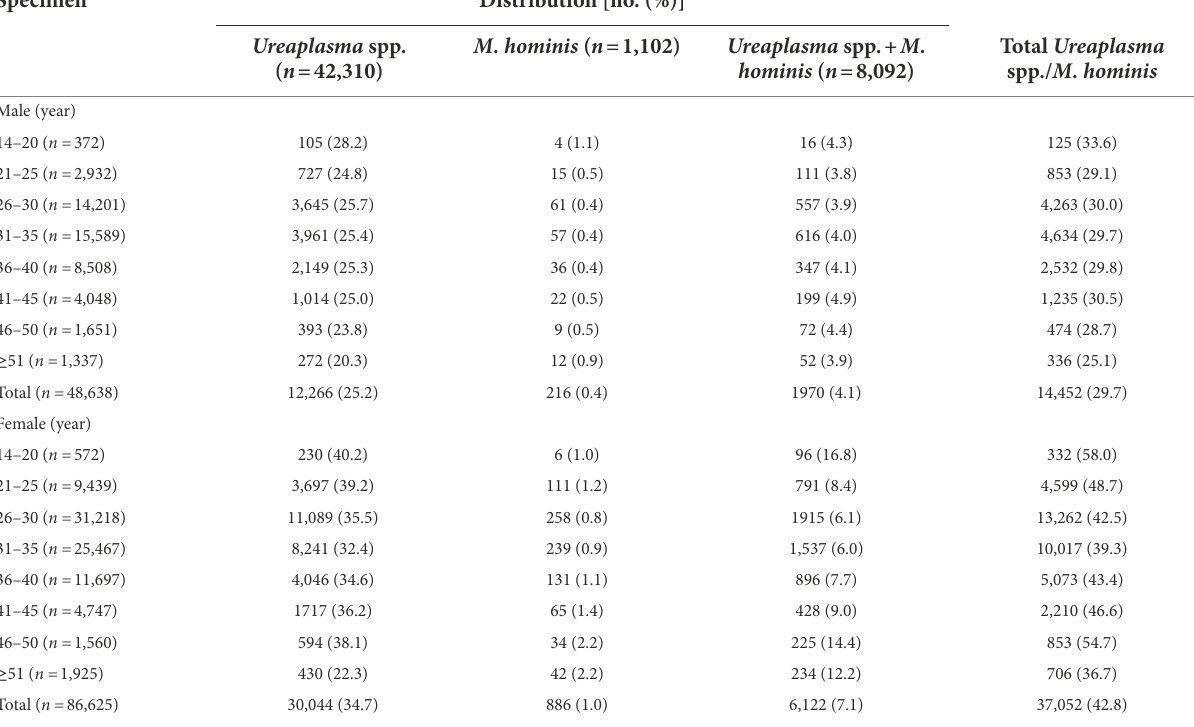
TABLE 1 Distribution of Ureaplasma spp. and M. hominis in the two sexes by age from 2013 to 2019. Specimen